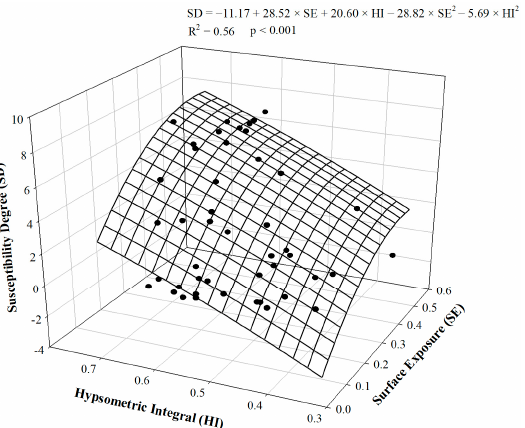
Figure 15. Fitting relationship for SD, SE and HI values. SDs are the susceptibility level defined by us, which can be considered as semi-quantitative values. HIs represent the geomorphic development status of gullies, which are calculated quantitative values. SEs represent the land surface exposure, which are calculated quantitative values. R 2 of fitting model is 0.56, with p < 0.001. There is a good slope trend based on the three variables. Since there are no-continuous values on the axes, it is not ruled out that there is a better fitting equation.